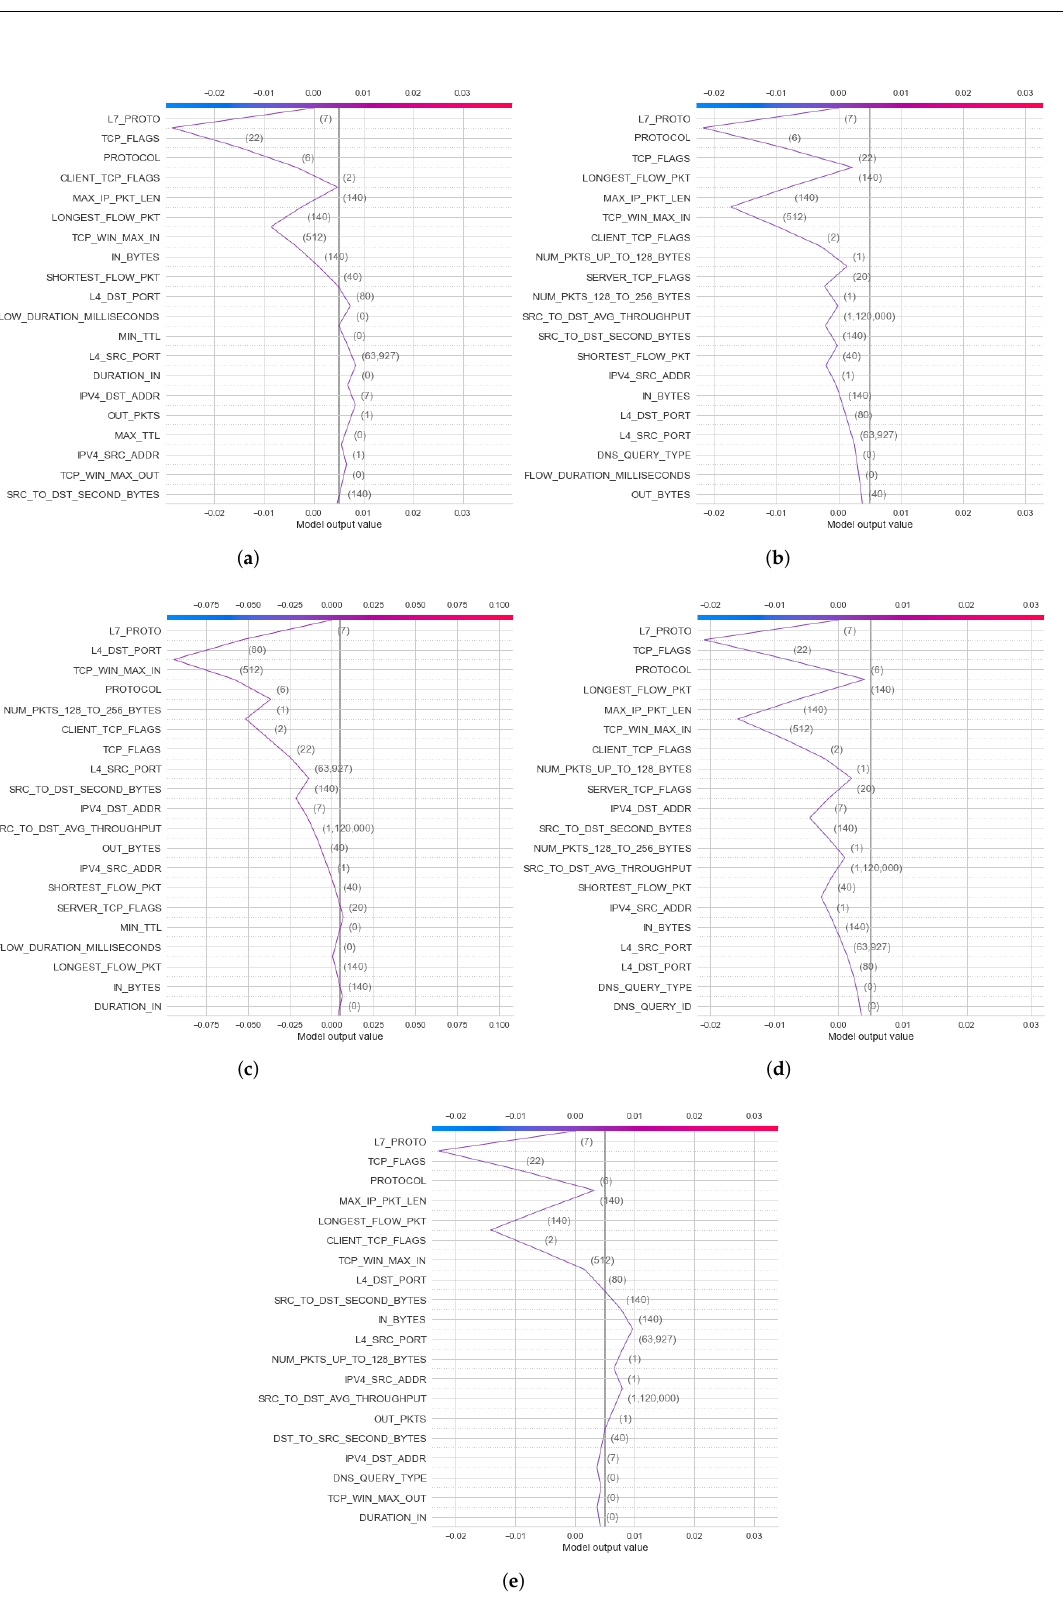
Figure 15. Decision plot results of local explanation for NF-BoT-IoT-v2 dataset in five Cat output values: ( a ) 0—DoS; ( b ) 1—DDoS; ( c ) 2—Reconnaissance; ( d ) 3—Benign; ( e )